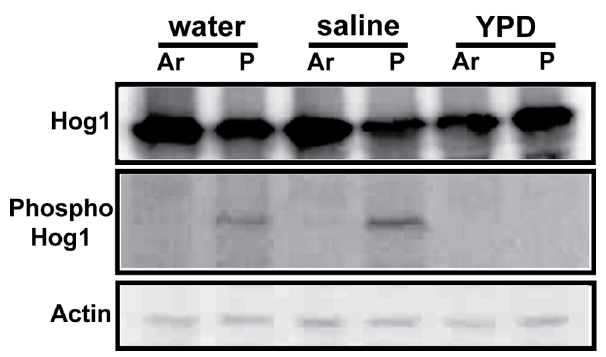
Figure 4. Phosphorylation of HOG1 MAP kinase after Ar gas and plasma treatment analyzed by Western blot. The levels of Hog1p expression and phosphorylation are shown in the first and second panel, respectively. The third panel shows the Western blot for actin as loading control. Total protein was extracted from the cells treated with Ar gas and plasma in water, saline, and YPD for 3 min, and run on a 12% SDS-PAGE (sodium dodecyl sulfate polyacrylamide gel electrophoresis)